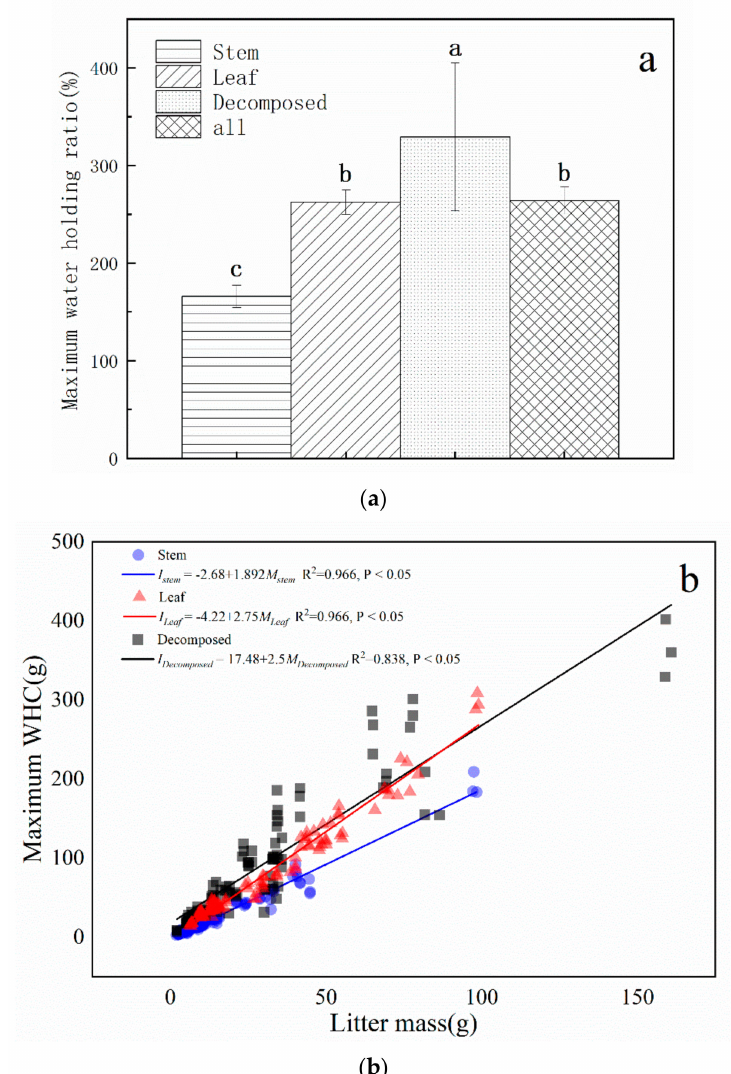
Figure 5. ( a ) The water-holding ratio of stem, leaf and decomposed parts of litter. ( b ) Linear fitting of the mass of stem, leaf and decomposed with its water-holding capacity (WHC) in all